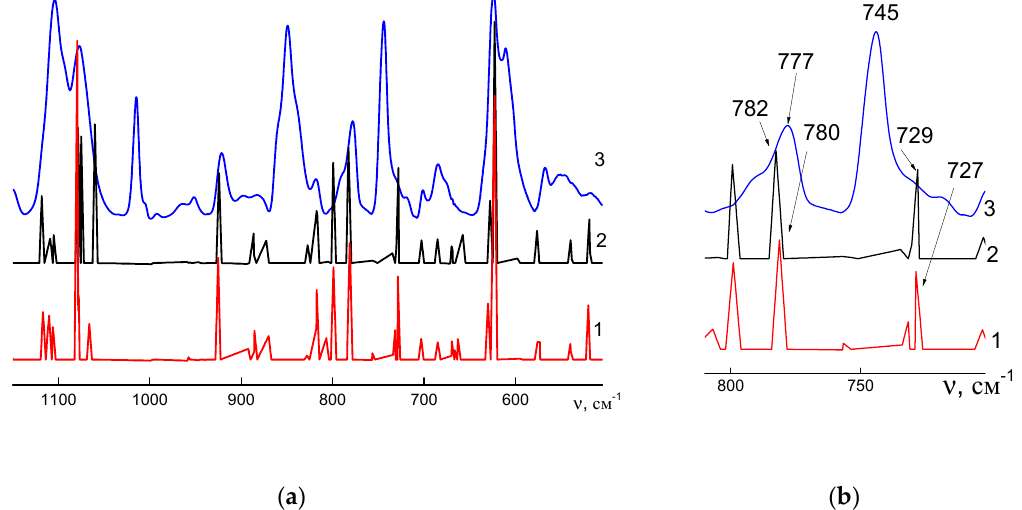
Figure 1. Fragments of theoretical vibrational spectra of models I and II of Im–Ph–Im’ unit in the region of 1050–500 cm –1 ( a ) and the absorption of the characteristic frequencies of the models ( b ), curves 1 and 2 , and a fragment of the IR spectrum of the Ultem film ( curve 3 ).